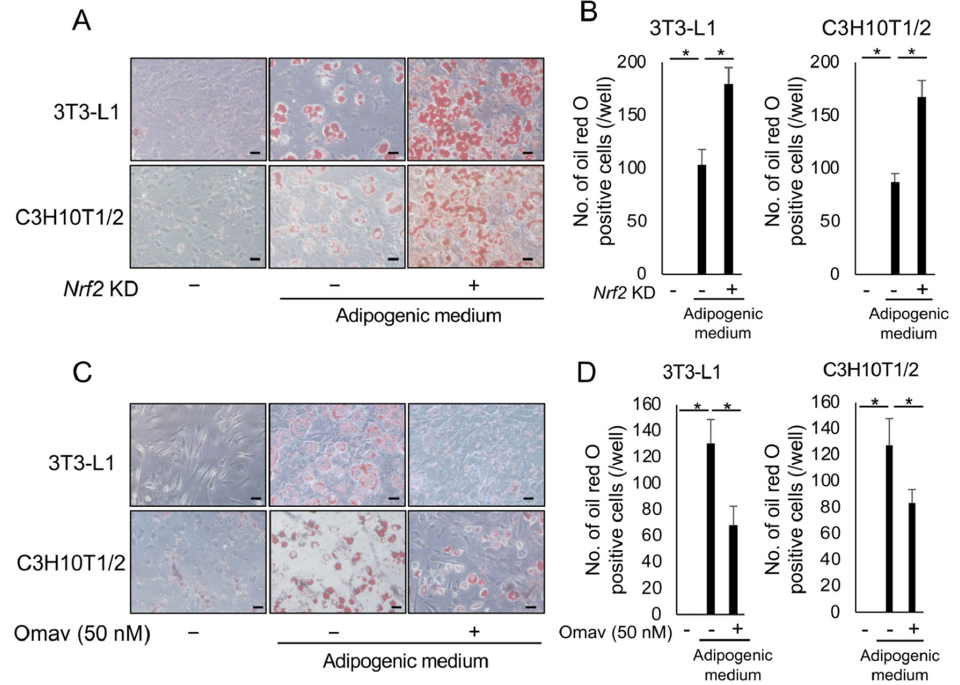
Figure 5. Nuclear factor erythroid 2 ‐ related factor 2 (Nrf2) plays an important role in adipocyte dif ‐ ferentiation. ( A ) Nrf2 knockdown 3T3 ‐ L1 and C3H10T1/2 cells were cultured in an adipocyte